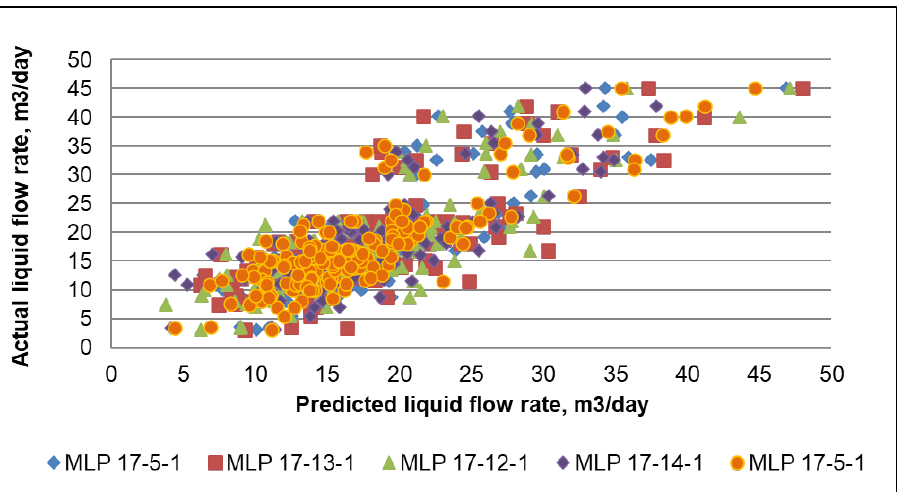
Figure 4. Results of training neural networks with different architectures. The second selected forecasting method was the Support Vector Machine method. However, with the modification of the parameters influencing the learning productivity, the best productivity value achieved was 0.79 for the training selection and 0.78 for the test selection with parameters — kernel type = radial basis function, gamma = 0.16, C = 5, epsilon = 0.2. MAPE — mean absolute percentage error; STD — standard deviation; SEM — standard error mean, RMSE — root mean square error. Table 4. Statistical measures of the proposed models.